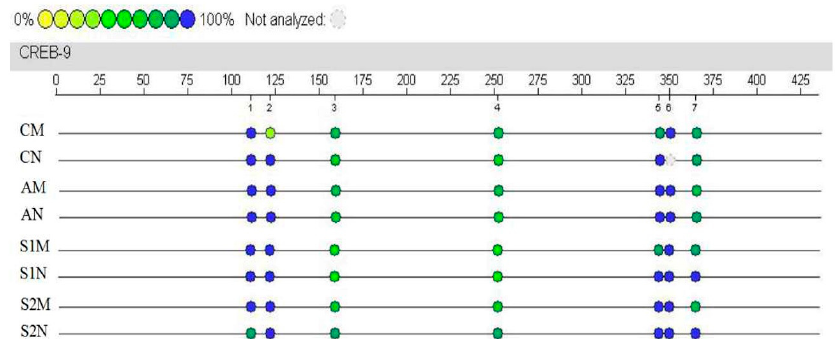
Figure 8. DNA methylation rate at the CpG site of CREB gene in rat hippocampus under various treatment conditions. The fragment containing nucleotide 56–470, with concentrated CpG sites, was selected as the target sequence. Abbreviated group names: CM—Saline-treated controls with Morris water maze training; CN—Saline-treated controls without Morris water maze training; AM— D -galactose injected rats received Morris water maze training; AN— D -galactose injected rats without Morris water maze training; S1M and S1N—Swimming exercise training before the D -galactose injection period with or without Morris water maze training; and S2M and S2N—Swimming exercise training during the D -galactose injection period with or without Morris water maze training.